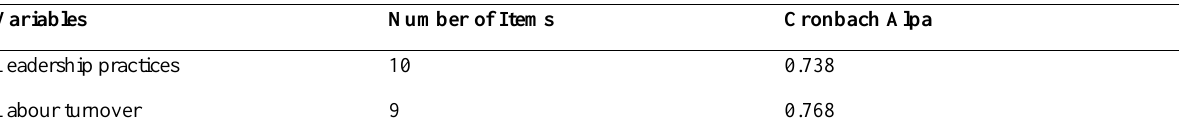
Table 2: Cronbach Test